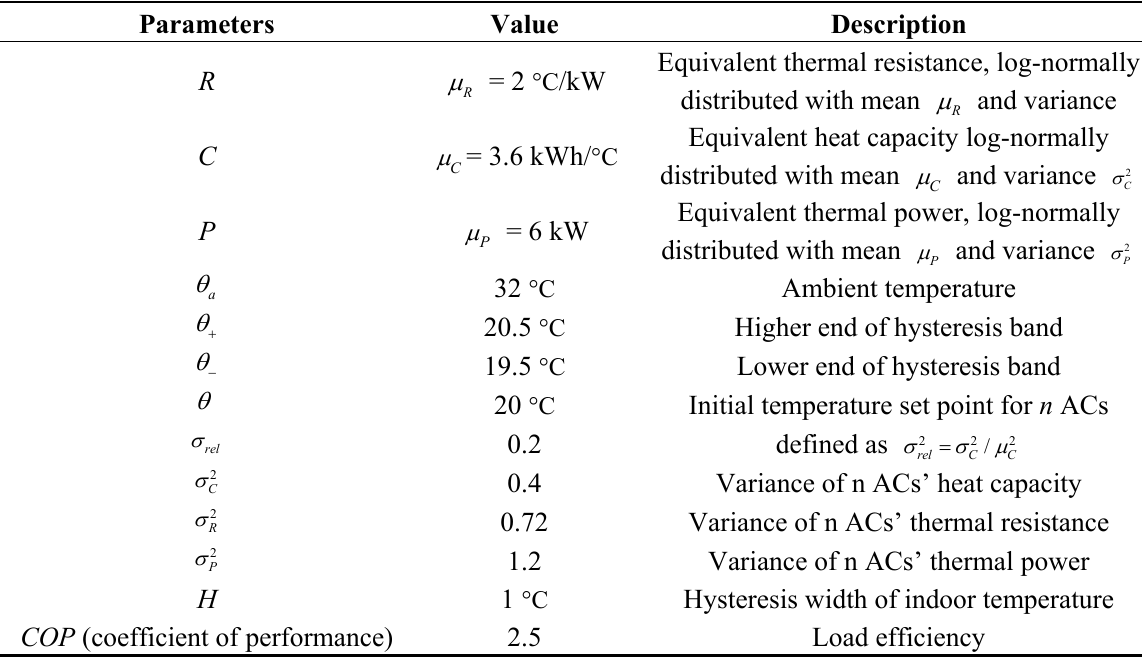
Table 2. Parameters of the air